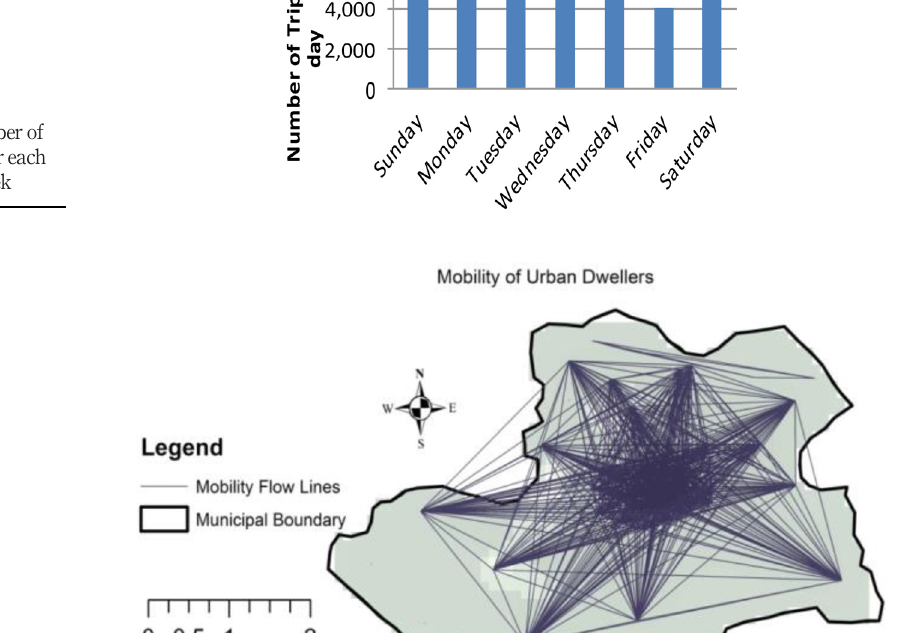
Figure 6. E-taxi trips characteristics in the study